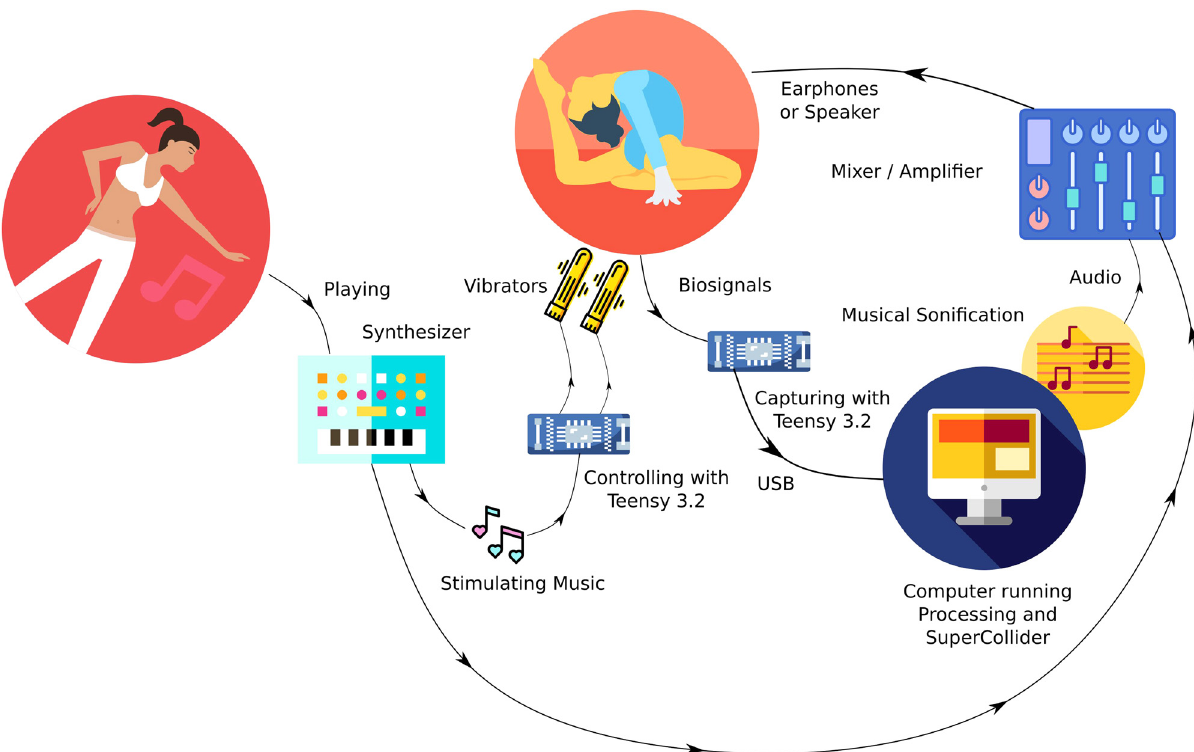
Figure 27: Dance performance using one PLAY ME